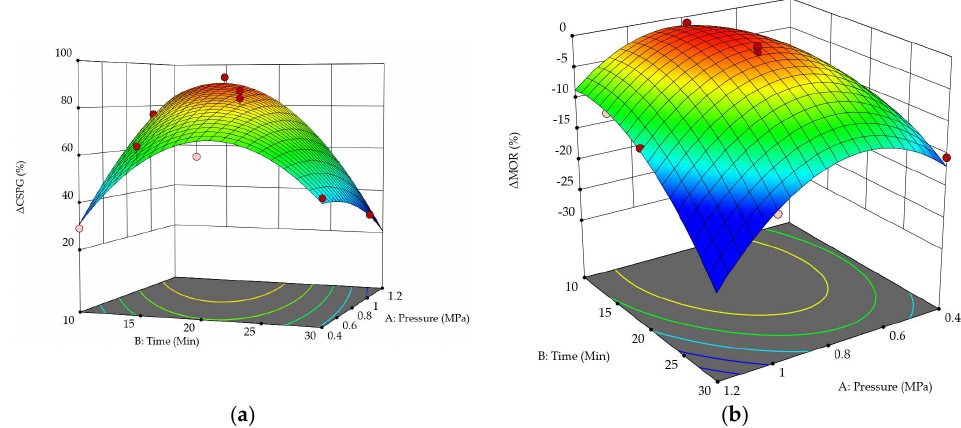
Figure 5. Three-dimensional surface and contour plot showing the effects of impregnation pressure and impregnation time on Δ SCPG and Δ MOR : ( a ) Δ SCPG ; ( b ) Δ MOR .